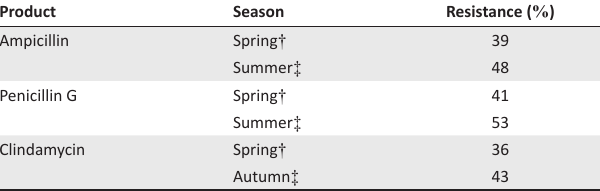
TABLE 3: Prediction of expectation of Staphylococcus aureus antibiotic resistance to ampicillin, penicillin G and clindamycin for different seasons where significant differences were shown according to the analysis using the general linear mixed model.